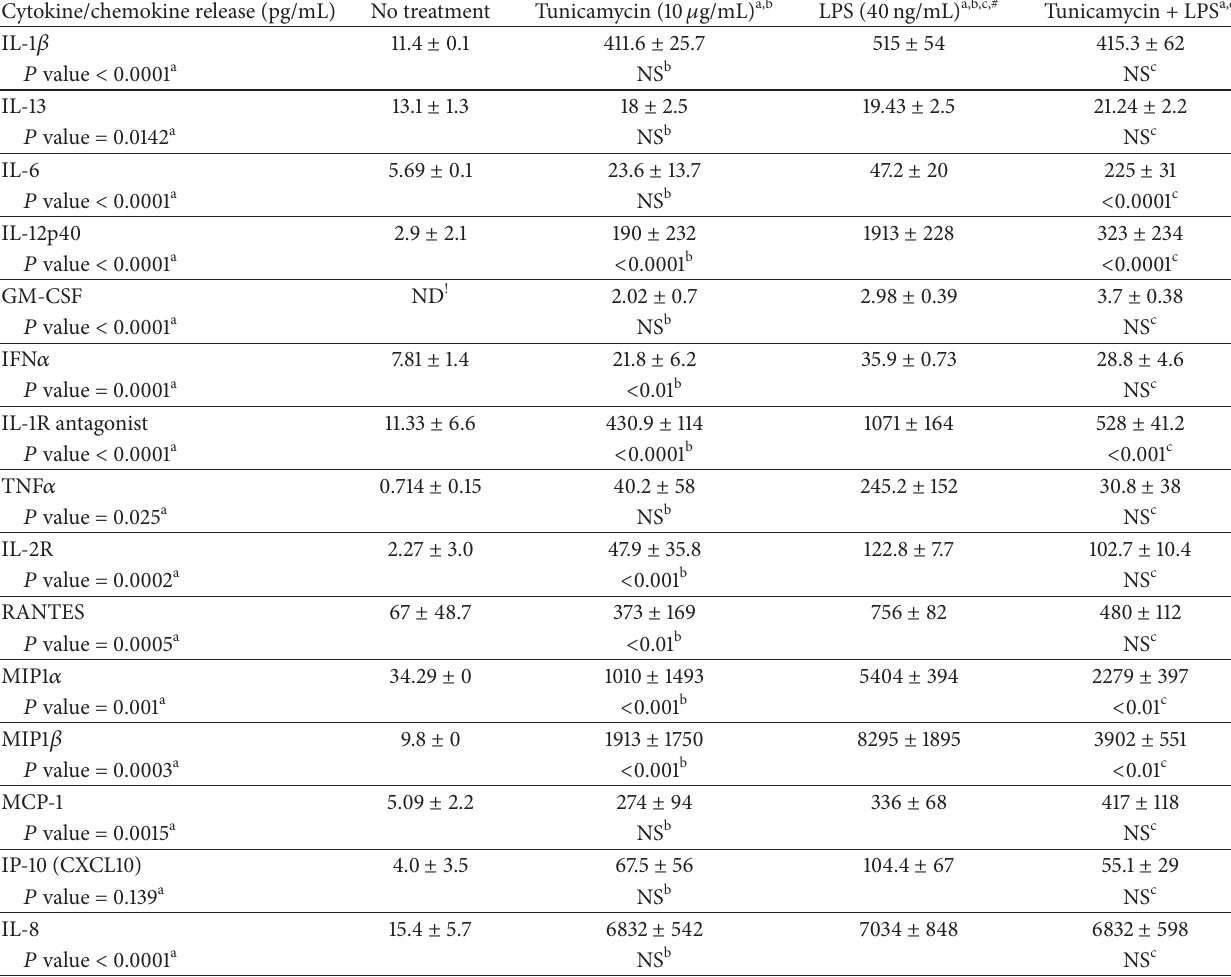
Table 1: Cytokine and chemokine release from THP-1